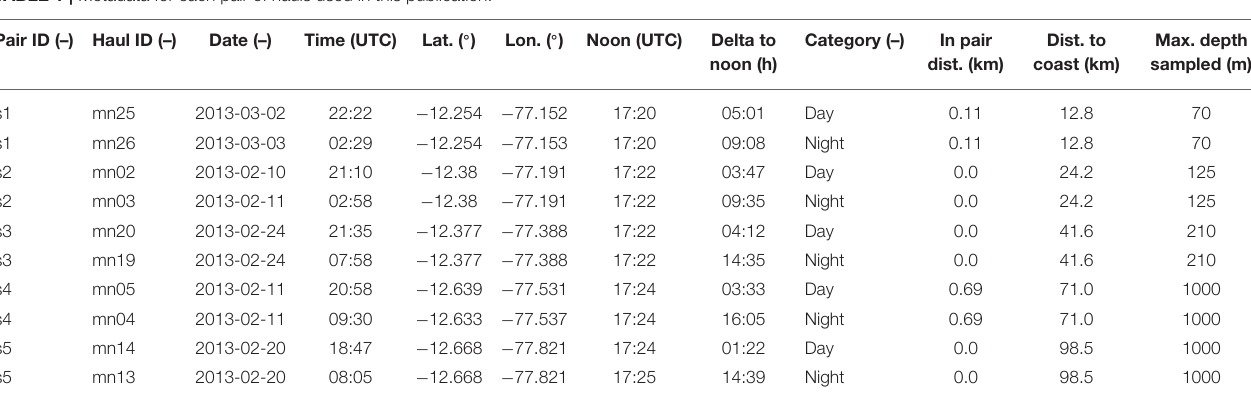
TABLE 1 | Metadata for each pair of hauls used in this